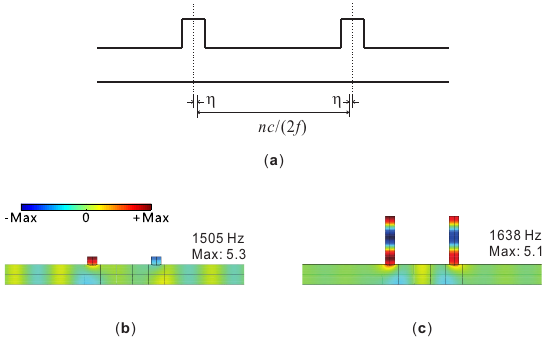
Figure 6. ( a ) schematic of a locally resonant Fabry-Perot interferometer formed by localized reflections. Reflections on the resonators are effectively shifted by distance η from the grafting center. Fabry–Perot resonances are formed when the separation l between resonators is the sum of an integer number of half-wavelengths plus twice distance η ; ( b , c ) normalized pressure distributions at resonance for locally resonant Fabry-Perot interferometers in case of short or long tubes, for l = 4 a . The color scale is for pressure normalized with respect to the maximum pressure